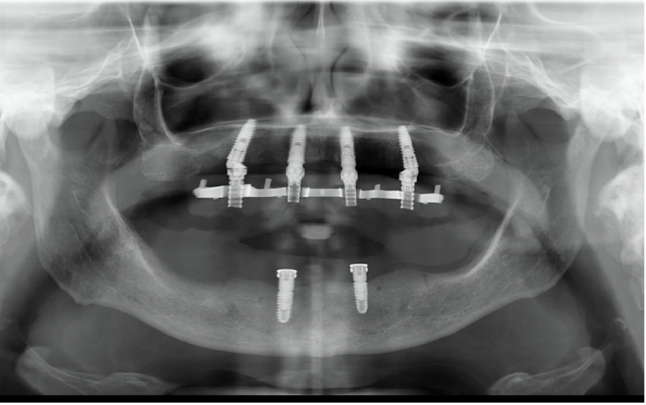
Figure 13. Screw-retained, temporary restoration after finishing.